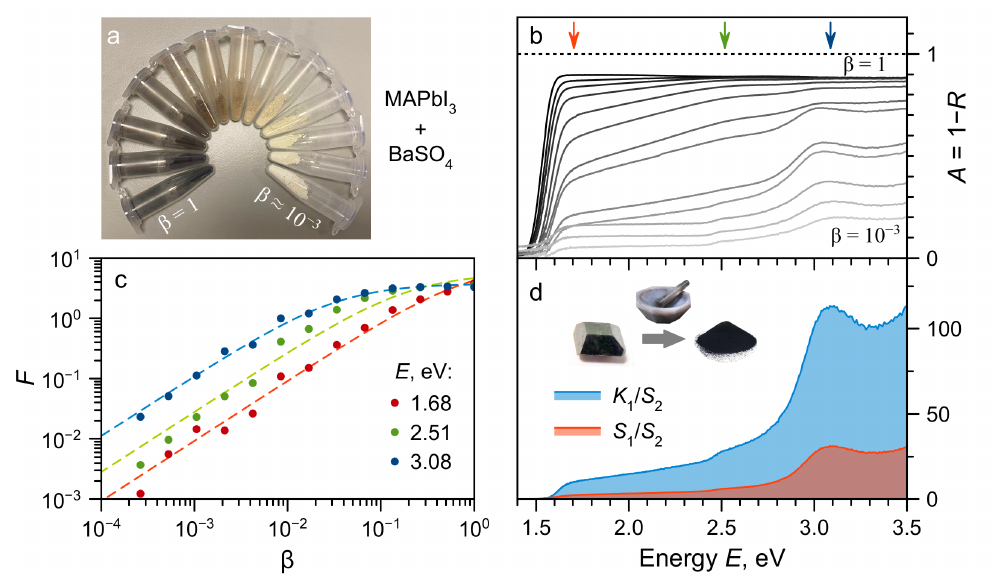
Figure 1. ( a ) Vials with mixtures of MAPbI 3 and BaSO 4 powders starting from undiluted MAPbI 3 ( β = 1) and halving the mass fraction for every next vial clockwise. Note the appearance of the material colour at β > 0.1 (sixth and further vials). ( b ) DRS spectra of powders mixtures from ( a ). ( c ) Dependence of the Kubelka–Munk transformation F of DRS data on the volume fraction β for different light energies (dots). Dots color corresponds to the energies marked by arows in ( b ). Dashed curves—fit by Equation (3). ( d ) Relative absorption K 1 and scattering S 1 coefficients of MAPbI 3 S 2 S 2 extracted from DRS data fitting. Inset shows the pulverization process